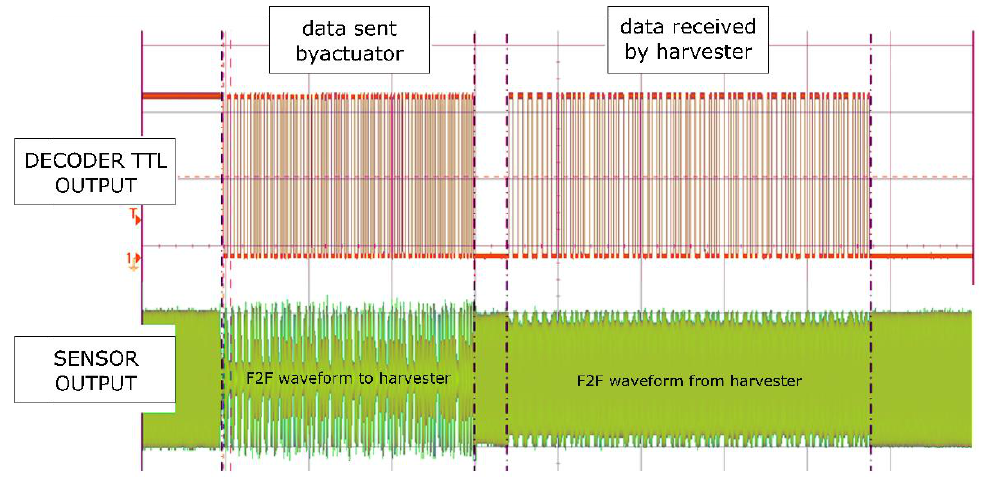
Figure 10. Graphic presentation of the results of power and data transfer.